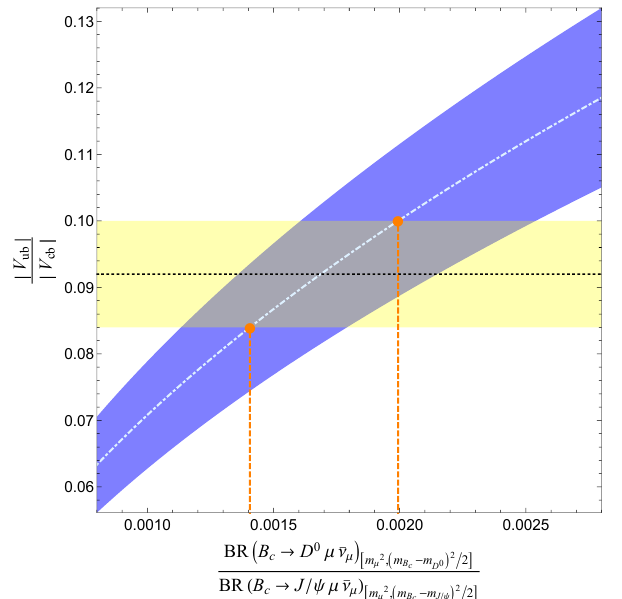
Figure 11 . The prospect for j V ub j = j V cb j determination from R the PDG value of j V ub j = j V cb j , eq.